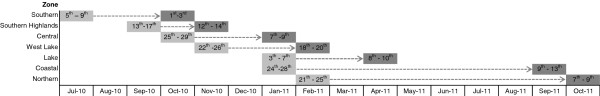
Universal Coverage Campaign implementation timetable, mainland Tanzania. The Universal Coverage Campaign was implemented on a rolling basis from one zone to another. Light grey indicates the household registration dates and dark grey the LLIN issuing dates in the corresponding zones.